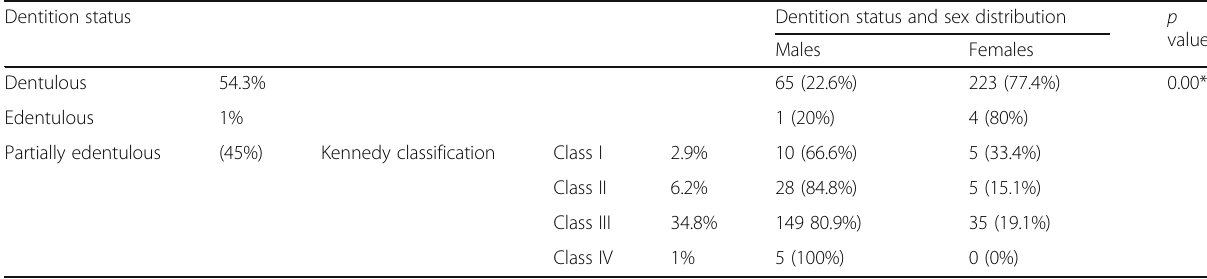
Table 7 Dentition status and pattern of tooth loss Dentition